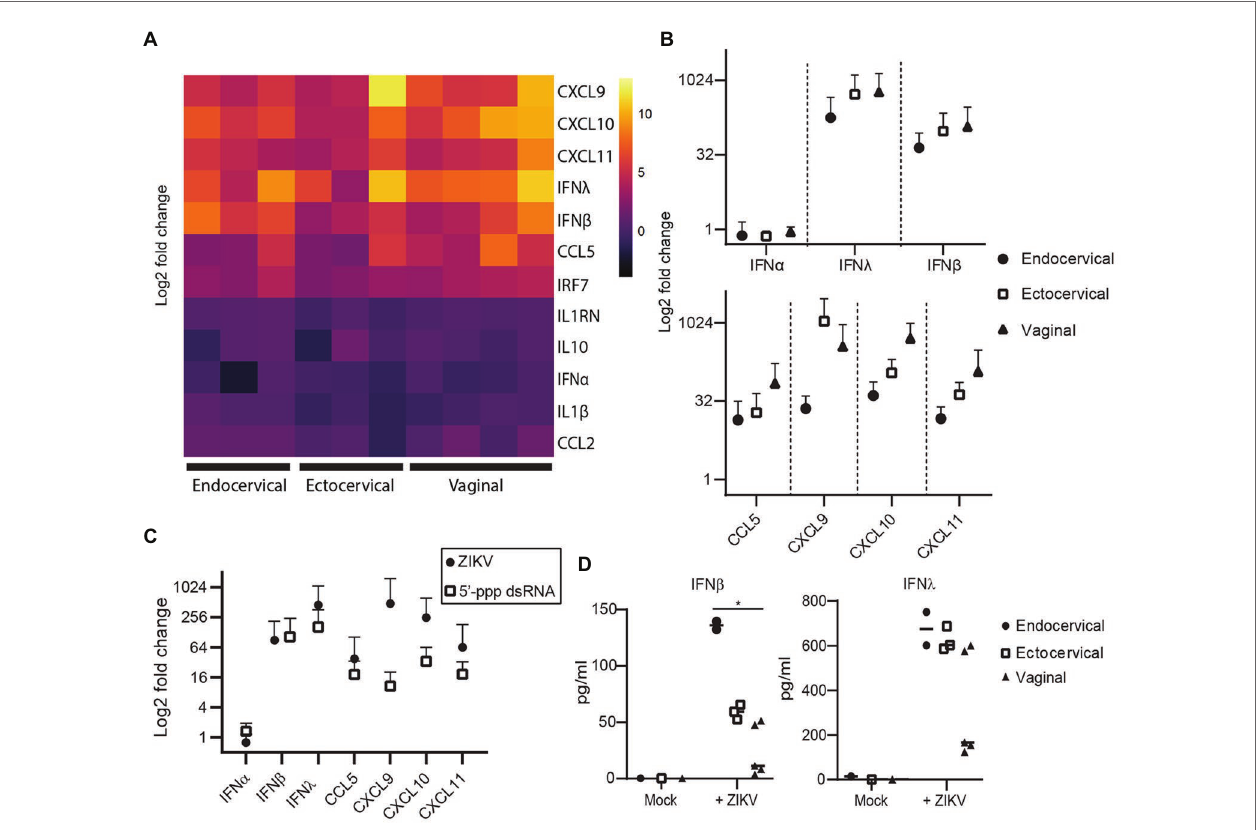
FIGURE 2 | Immune response of genital epithelial cells to ZIVK infection. (A) RNA from cells infected with ZIKV at an MOI of 1 for 72 h was analyzed for the indicated genes by quantitative PCR (qPCR). Heatmap of log2 fold regulation of each analyzed gene compared to mock infected control cells, averaged from two independent wells. Cell type is indicated on the x -axis; each column is a separate cell line. (B) Numerical representation of the data shown in panel (A) averaged for each tissue type. Error bars indicate one standard deviation. (C) Three epithelial cell lines (one for each tissue type) were treated with 10 μ g/ml of the RIG-I agonist 5 ' ppp-dsRNA complexed with LyoVec ( Invivo Gen), or infected with ZIKV at an MOI of 1 for 24 h. RNA was isolated and gene expression of the indicated cytokines was measured by qPCR. Plotted is the mean response of all epithelial cell lines to ZIKV infection at 72 hpi compared to the mean response to 5 ' ppp-dsRNA. (D) Supernatants from cell cultures in (A) were analyzed for IFN α , IFN β , and IFN λ using a Meso Scale Discovery assay. IFN α was below the limit of detection in all samples and is not shown. Concentration of IFN β and IFN λ in ZIKV-infected and mock-control cell culture supernatants are shown, each point is the average of two independent wells, and at least two cell lines from each tissue type were tested. Horizontal bars indicate mean concentrations. Differences between cell types were tested by one-way ANOVA with Tukey’s test. * p <